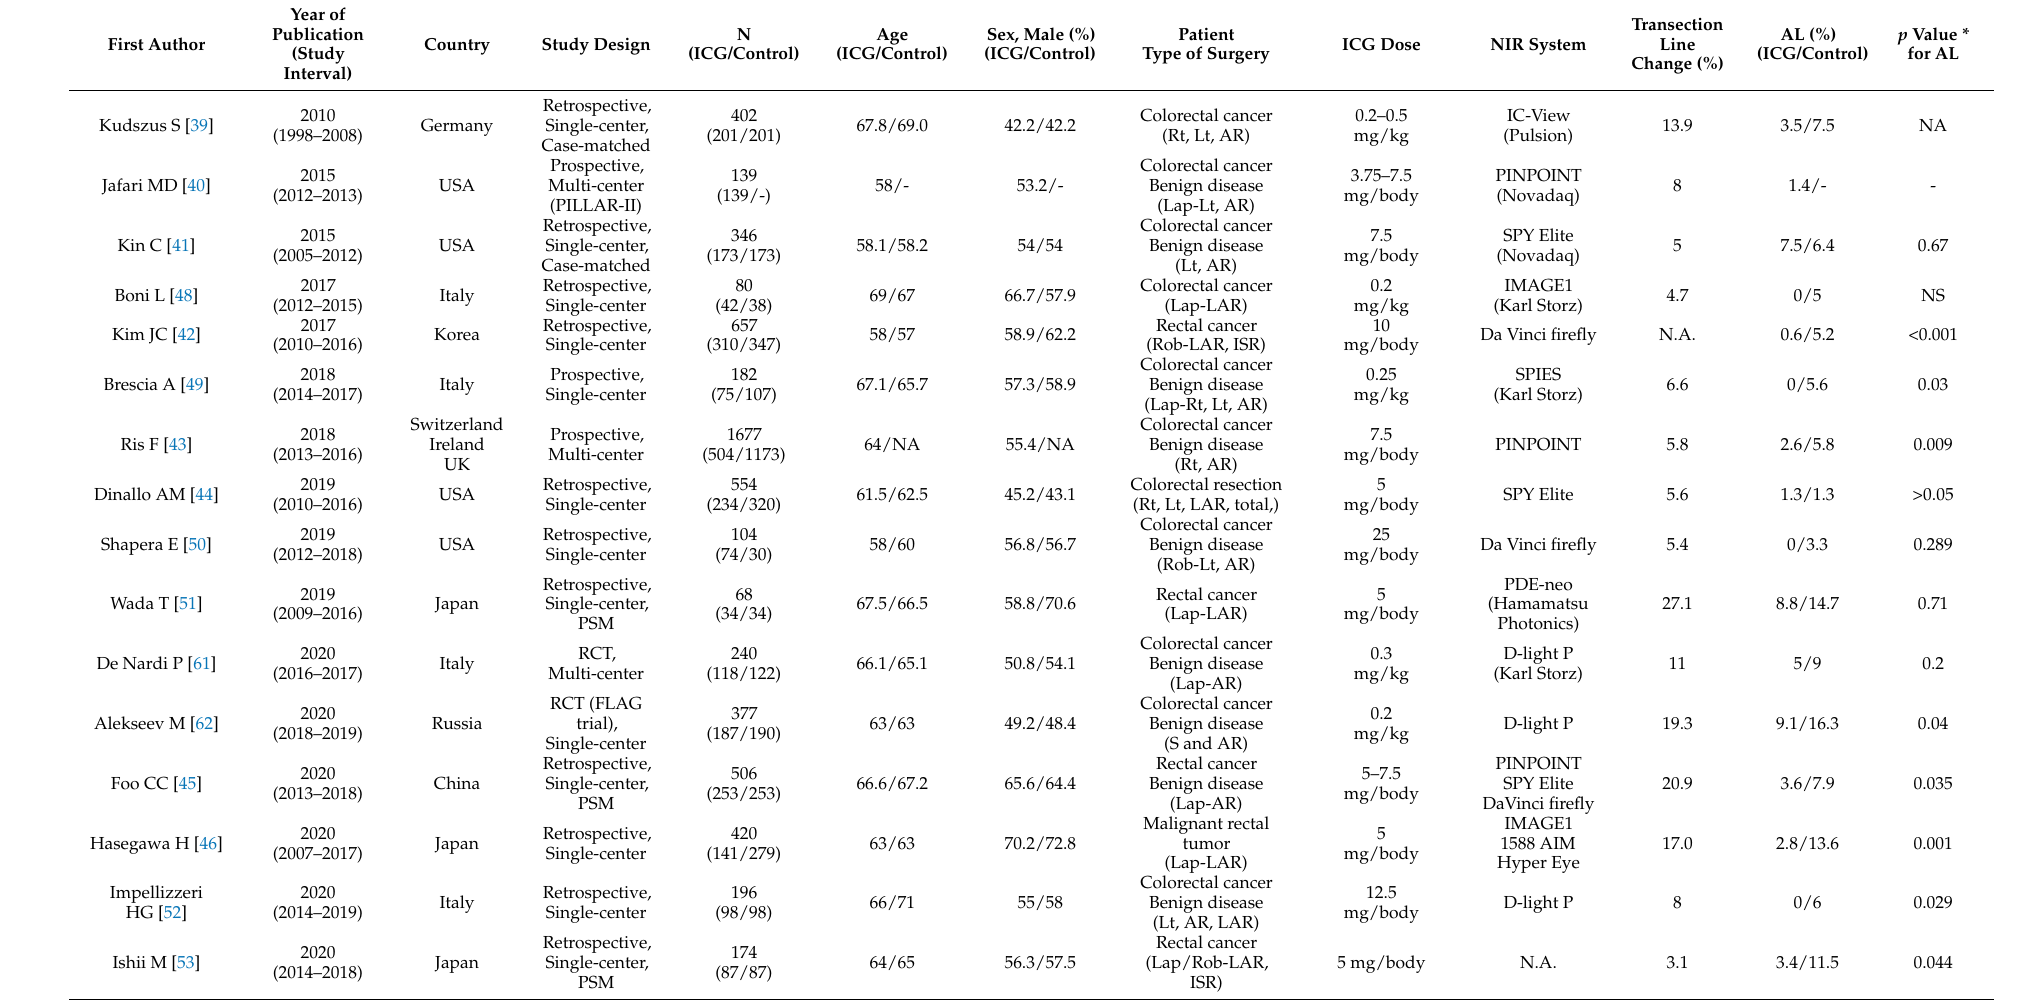
Table 1. Summary of the data from clinical studies investigating the reduction of anastomotic leakage with